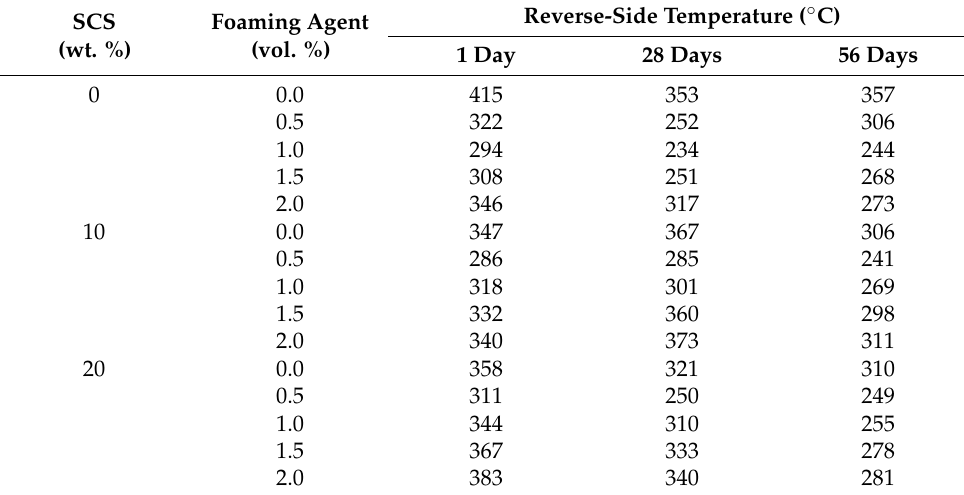
Table 5. Reverse-side temperature of lightweight